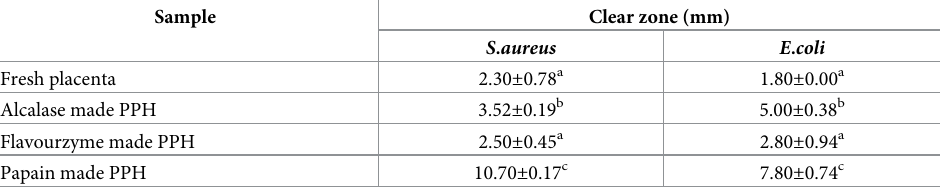
Values are given as mean ± standard deviation from six determinations. Different letters in the same row indicate significant differences ( P <